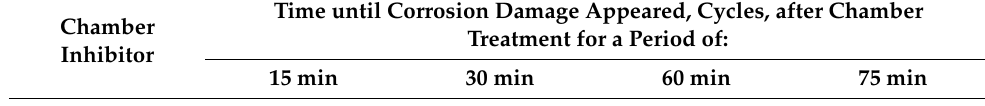
Table 9. Protective aftereffect of adsorption films formed on brass in CIN vapors at 120 ◦ C and at various τ CT in the salt fog chamber.